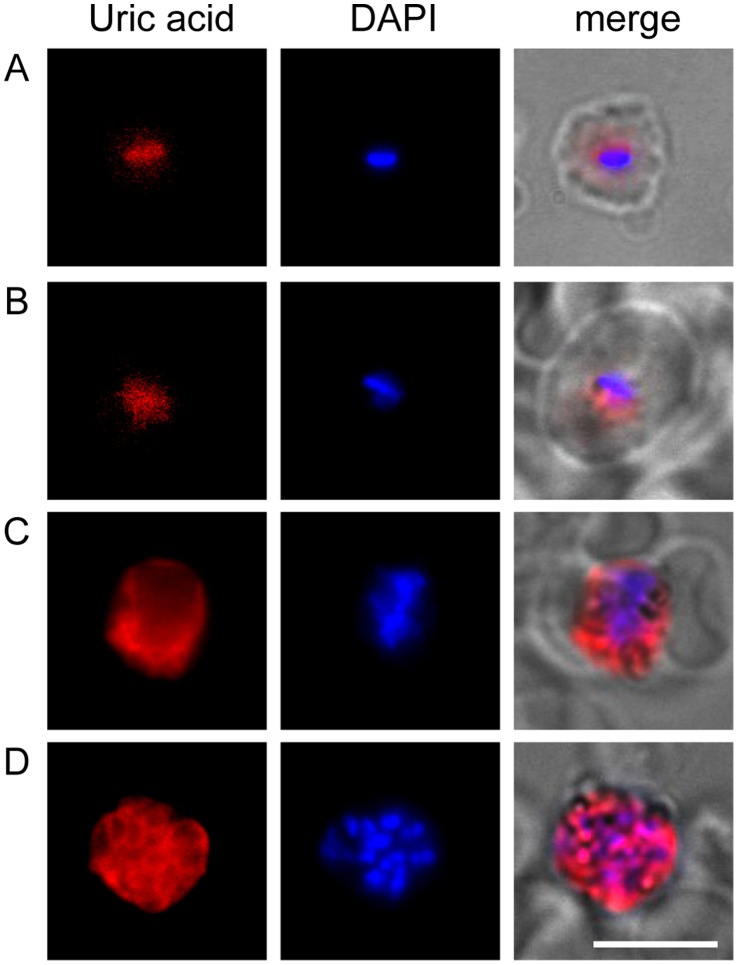
Blood-stage parasites from human malaria patients in the Peruvian Amazon show accumulation of UA precipitates.Blood samples from patients infected with P. falciparum (A) or P. vivax (B–D) exhibit uric acid immunostaining (red), and DAPI labeling of parasite nuclei (blue). Representative examples of rings (A, B), trophozoites (C) and schizonts (D) are shown. Bar is 5 µm.